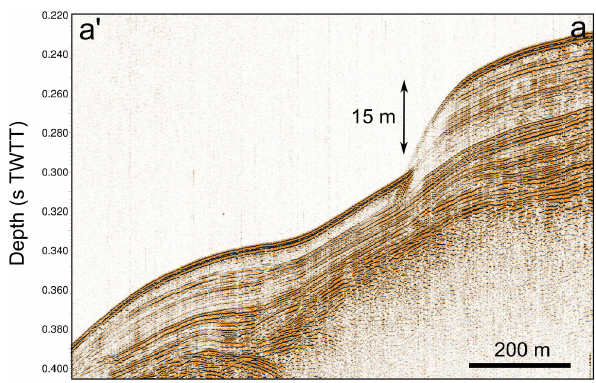
Figure 8. Sparker seismic profile illustrating a submarine landslide head scarp that is probably linked to the MTD 19. See the location of the profile in Fig.